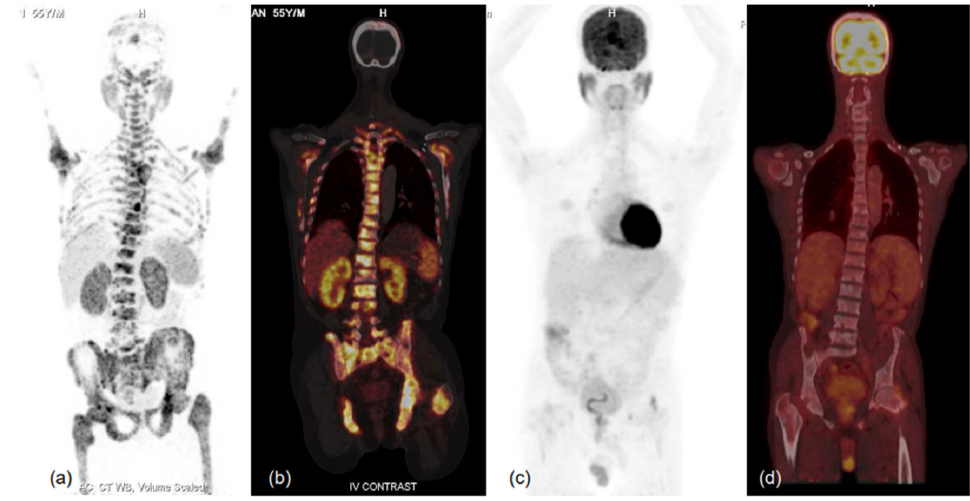
Figure 6. MIP images of 68 Ga-PSMA-11 ( a , b ) and FDG ( c , d ) PET-CT scans and corresponding fused coronal images (b- 68 Ga-PSMA-11 and d-FDG PET-CT scans) in bone window showing PSMA-expressing multiple sclerotic and marrow lesions involving almost the entire axial and